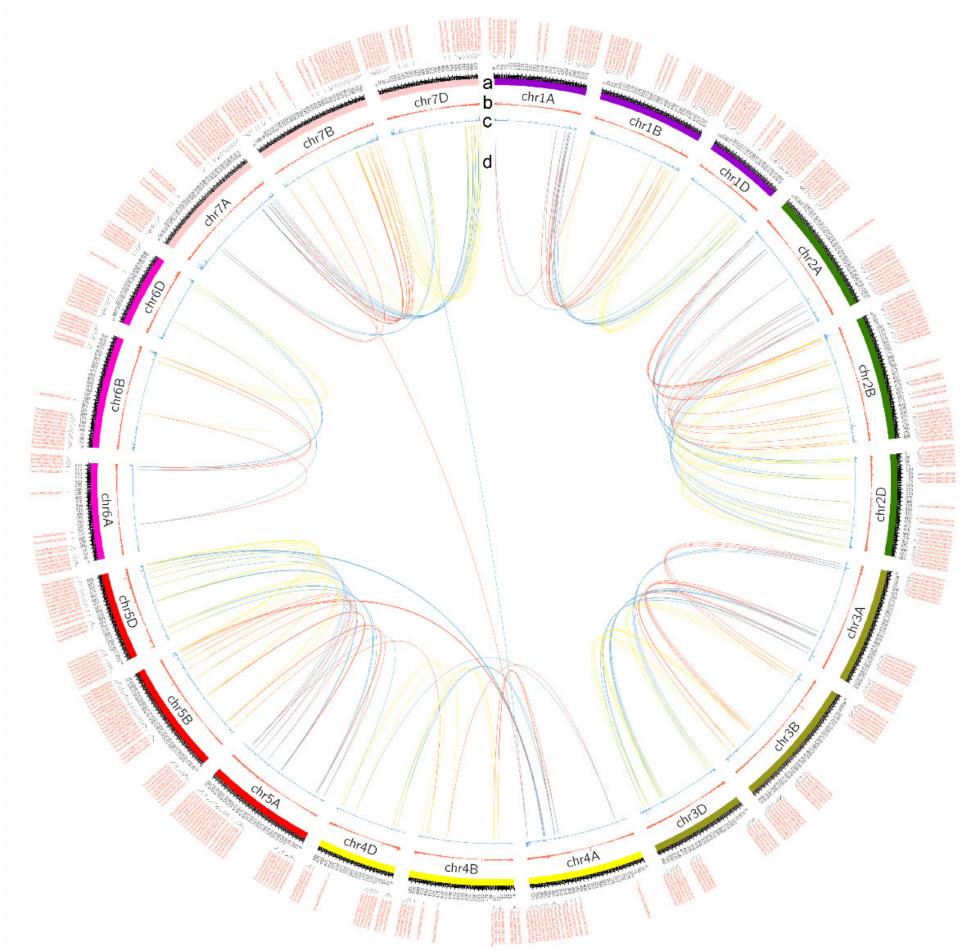
Figure 1. The summary of identified NLR proteins in wheat. ( a ) The Circos plot displays the genomic distribution of NLRs in 21 chromosomes; ( b ) the red bar represents the number of annotated high- confidence genes in each 200 Kb window and was plot using Circos; ( c ) the blue bar represents the number of NLRs in each 200 Kb window; ( d ) the synteny of paired NLR proteins on A, B, and D subgenomes. Red lines connect A and B subgenome; yellow lines connect B and D subgenome; blue lines connect A and D subgenome. This figure was plotted using